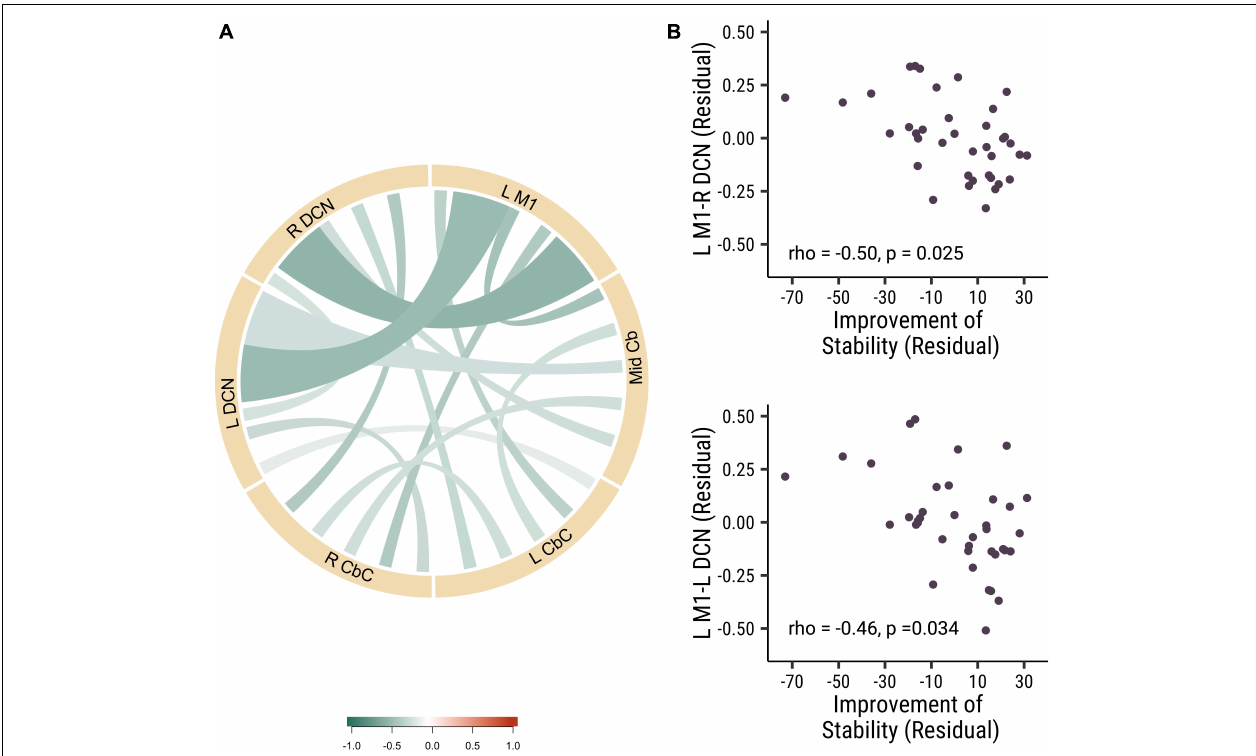
FIGURE 2 | The baseline functional connectivity of M1 to deep cerebellar nuclei was corelated with the improvement in trial-to-trial variability. (A) The correlation of different functional connectivity and the stability improvement in all participants. (B) The correlation between the functional connectivity of L M1-R DCN (rho = –0.50, p = 0.025; top panel) and L M1- L DCN (rho = –0.46, p = 0.034; bottom panel) functional connectivity and the stability improvements. Each point is one participant. (L M1 = left motor cortex; R CbC = right cerebellar cortex; L CbC = left cerebellar cortex; R DCN = right deep cerebellar nucleus; L DCN = left deep cerebellar nucleus; Mid Cb = midline